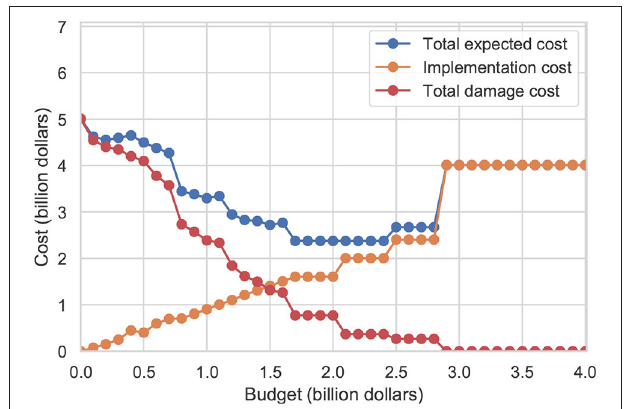
FIGURE 9 | The total expected cost of an optimal solution as a function of the prescribed budget for the Lower Manhattan area. Orange dots represent the implementation cost of the optimal protective strategy, red dots represent the corresponding total damage cost, and blue dots represent the sum of the orange and red dots (total expected cost). The total expected cost of the optimal solution (blue dots) varies significantly as a function of the prescribed